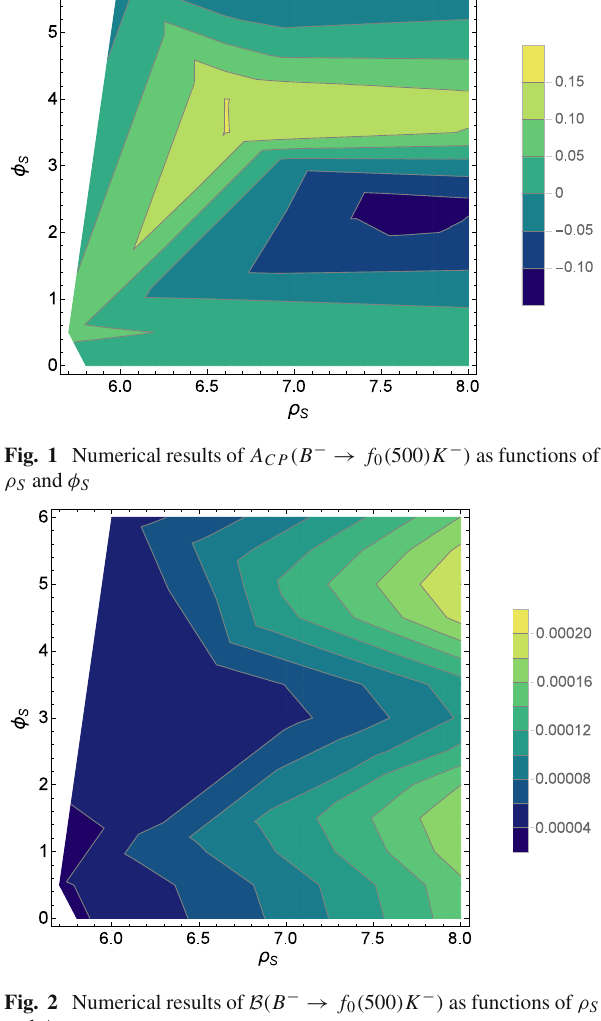
Fig. 2 Numerical results of B ( B − → f 0 ( 500 ) K − ) as functions of ρ S and φ